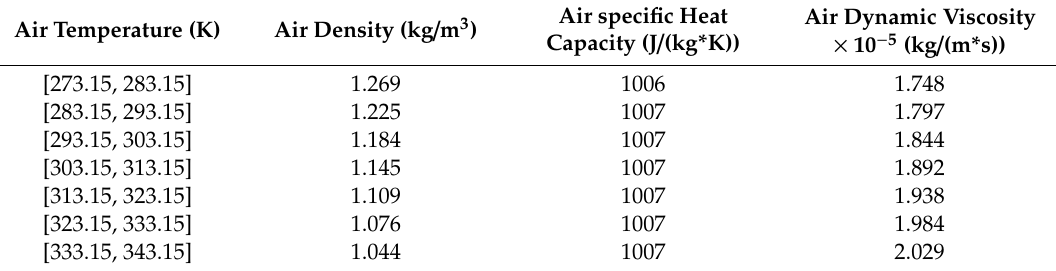
Table 3. Air density and air specific heat capacity under di ff erent temperature; Source: